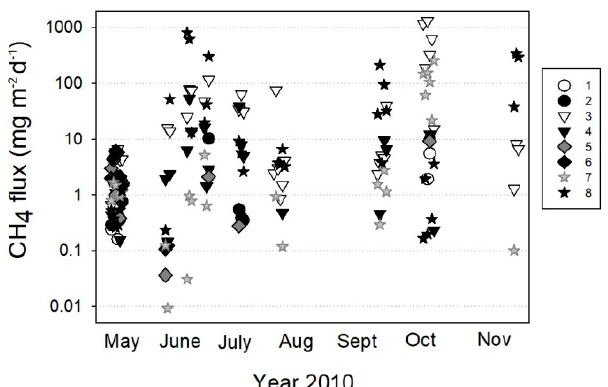
Figure 5. Net emissions of CH 4 reported for each chamber used in the downhill area. Symbols numbered in the legend from 1 to 8 refer to the 8 positions of the chambers in the field.